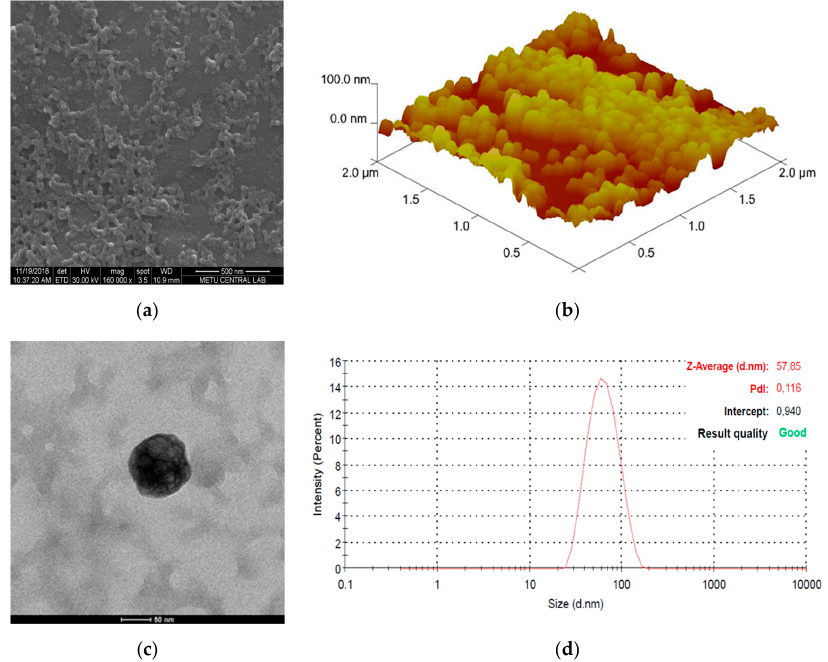
Figure 3. Nanoparticle characterization results: ( a ) SEM; ( b ) AFM; ( c ) TEM and ( d ) zeta-size.